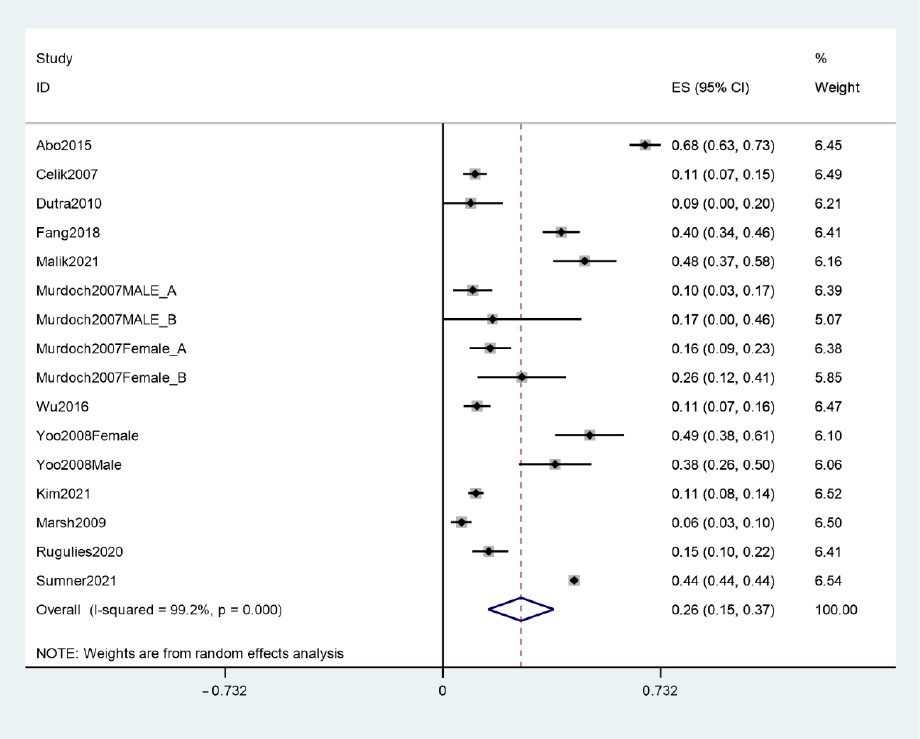
Figure 2. Meta-analysis of the prevalence of depression among workers who experienced SHWP. Similarly, eleven included articles reported odd ratios of depression as a result of SHWP. The results indicated that workers who experience SHWP have 2.69 higher odds of depression compared to workers who do not experience SHWP (see Figure 3); however, again, heterogeneity was high (82%).